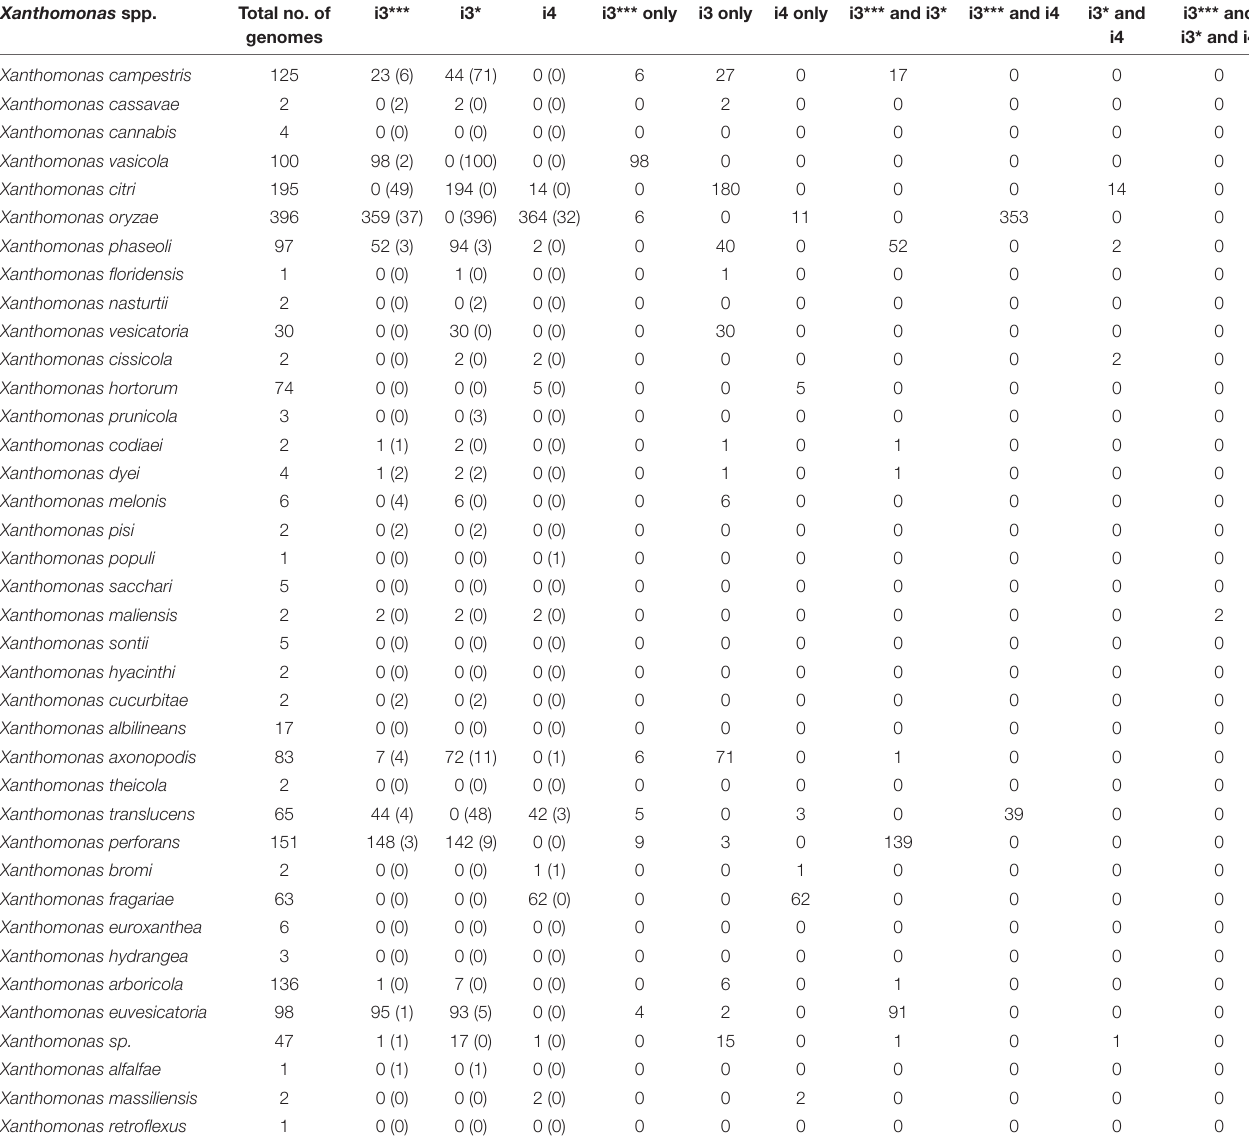
TABLE 1 | Analysis of T6 cluster distribution in genus Xanthomonas . Xanthomonas